Question: Write a caption explaining this figure to a reader.
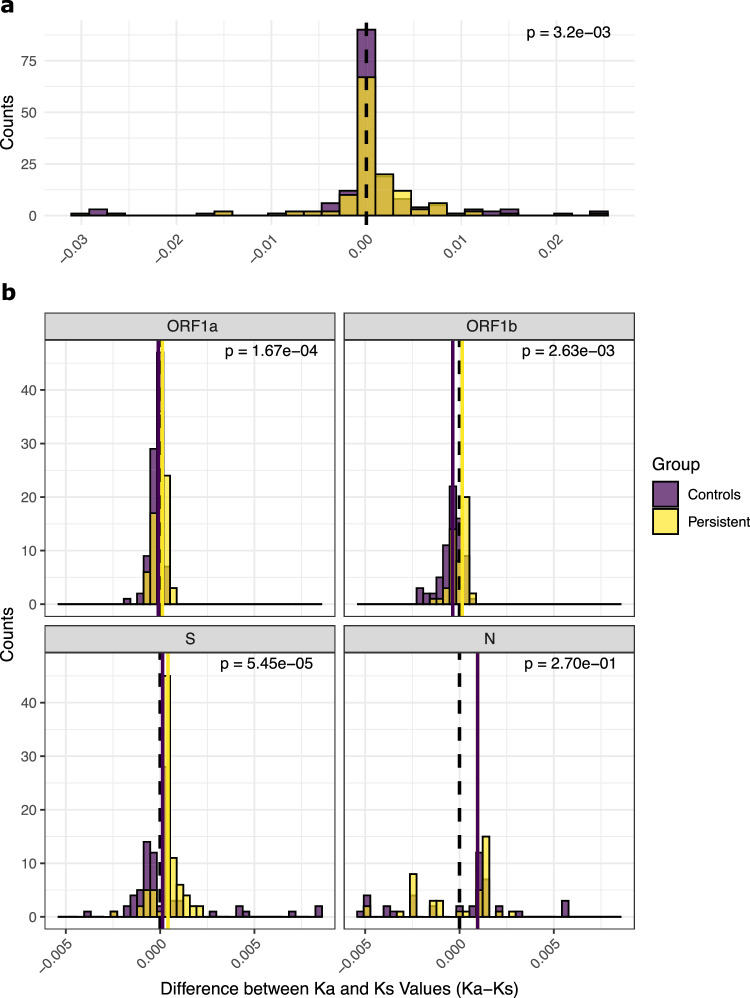
Answer: Differences in Ka and Ks values (Ka - Ks) across the genome and by coding region. a Difference in Ka and Ks values among individuals with persistent infections ( N = 135) and among individuals without persistent infections (controls, N = 167) with two or more available sequences. Ka and Ks represent the substitution rates per non-synonymous and synonymous site, respectively. The dotted line indicates a value of 0, and the solid lines represent median values. The p-value denotes the p-value from a two-sided two-sample Kolmogorov-Smirnov (KS) test comparing the distributions between the two groups. No adjustments were made for multiple comparisons. b Difference in Ka and Ks values in each coding region among individuals with and without persistent infections, specifically those with at least one mutation in the region. P-values are from KS tests as above. Source data underlying this figure can be generated using the custom code available at the repository described in the Code Availability statement.